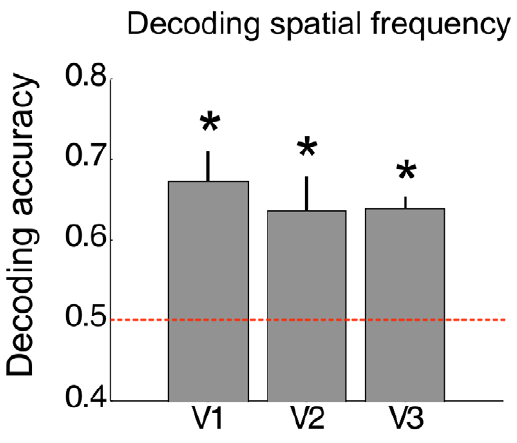
Figure 5. Decoding the spatial frequency. Accuracy obtained at 100 voxels (averaged across participants) for decoding between low and high spatial frequency is plotted for each ROI. Error bars depict standard error of the mean. Asterisks indicate whether accuracy was significantly above chance (permutation test, p , 0.01, Bonferroni